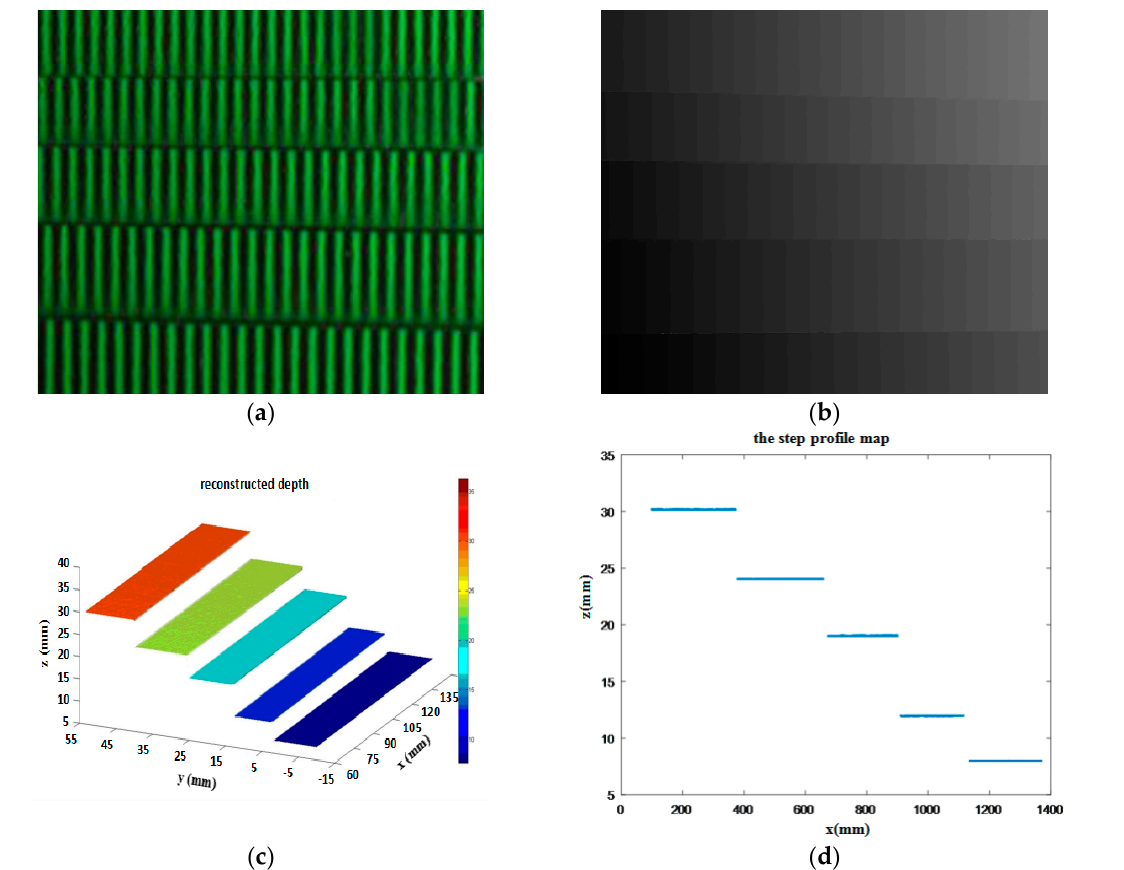
Figure 12. Measurements on the artificial specular step: ( a ) one captured fringe pattern reflected by the step; ( b ) one absolute phase map from the reflected fringe patterns; ( c ) measured 3D shape of the step and ( d ) profile map of the step.